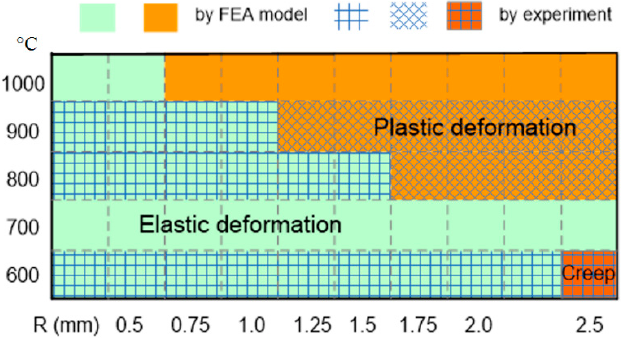
Figure 11. Evaluation of the prediction using the experimental observation.